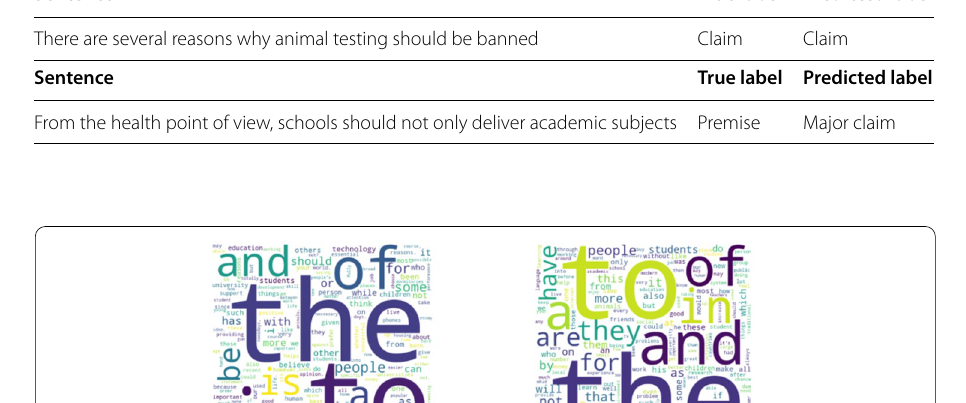
Table 4 Premise sentence prediction